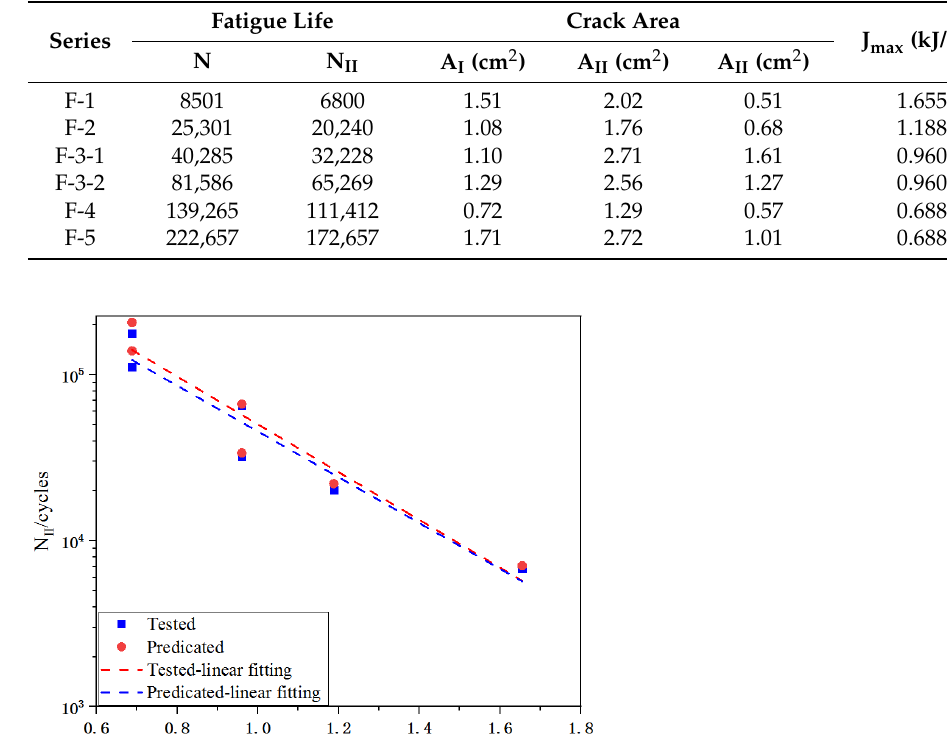
Table 5. Summary of the experimental data of UHTCC under flexural fatigue loading.